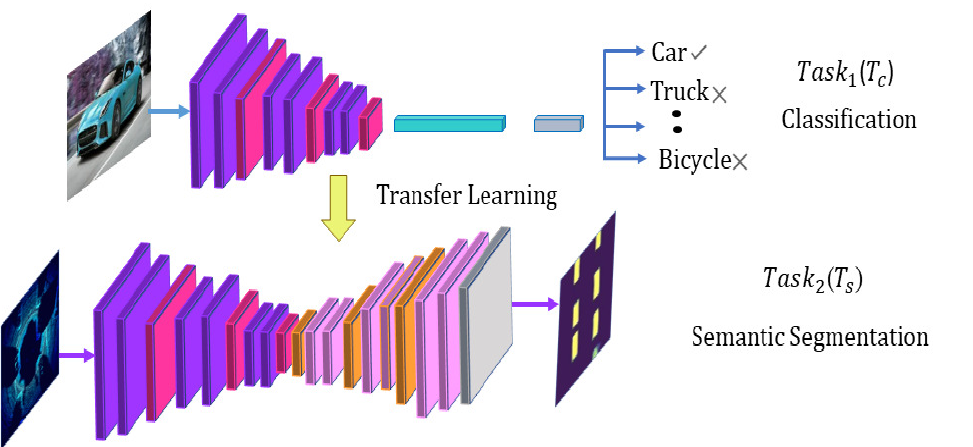
Figure 3. Transfer learning from classification to